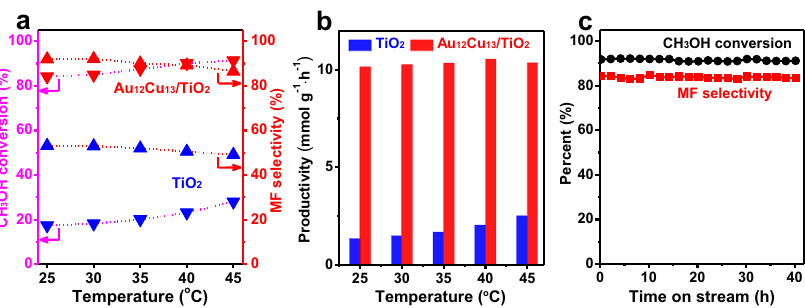
Fig. 6 Catalytic performance of Au 12 Cu 13 /TiO 2 in the photo-oxidation of methanol. a Catalytic performance as a function of temperature on TiO 2 (P25) and Au 12 Cu 13 /TiO 2 . b Formation rate of methyl formate (MF) over TiO 2 and Au 12 Cu 13 /TiO 2 catalysts. c Durability test of the Au 12 Cu 13 /TiO 2 catalysts at 25 °C. Reaction conditions: ~ 20 mg catalysts, λ = 365 nm, methanol (1.0 v %) and O 2 (0.5 v %) balanced with N 2 at the fl ow rate of 20 mLmin − 1